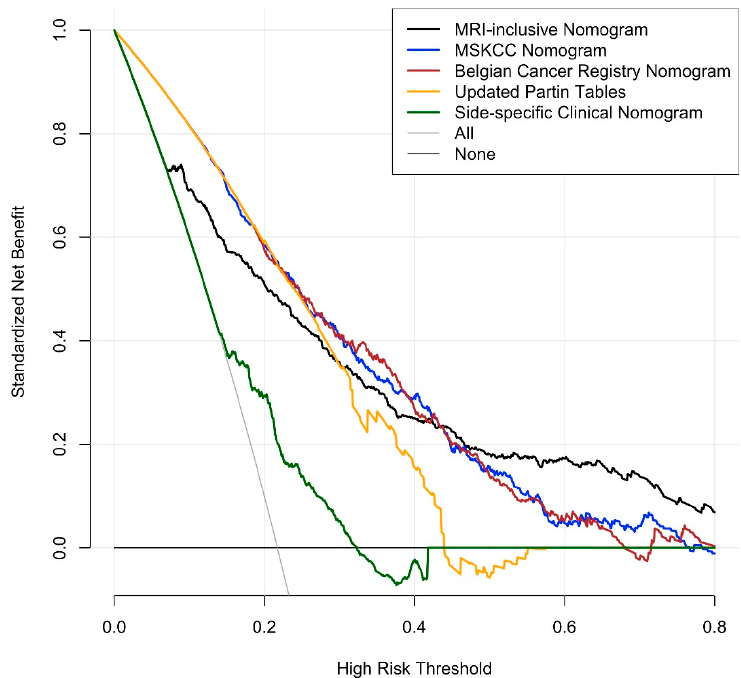
Figure 2. Decision curve analyses for the proposed MRI-inclusive nomogram and the benchmark models. The y -axis depicts the benefit of each nomogram to identify EPE correctly, and the x -axis refers to how clinicians appraise different outcomes in a given clinical context. A detailed guide for the interpretation of decision curves can be found in [30]. To further validate the diagnostic performance of the proposed nomogram, we per- formed additional analyses by using data from six institutions as training set and data from the others as validation set. This process was repeated on all 210 possible permuta- tions and yielded similar results as the bootstrap-validated model (AUROC: 0.821 vs. 0.828) (Table S1). The analyses were repeated without imputation of missing data and the AUROC of the MRI-inclusive nomogram was slightly lower compared with the bootstrap- validated model with imputed data (AUROC 0.799 vs. 0.828) (Table 4). Table 3. Performance statistics of the MRI-inclusive nomogram and the benchmark models.